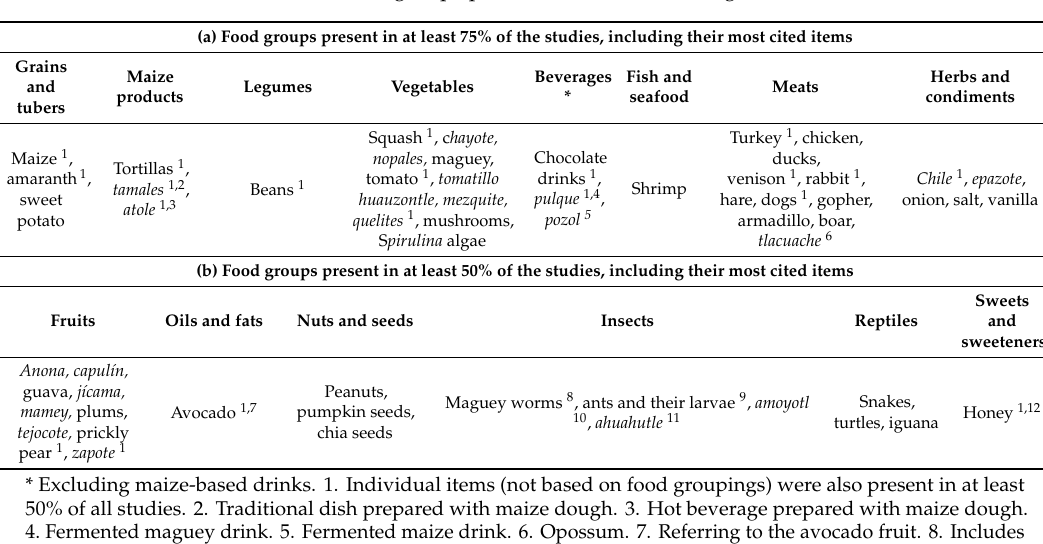
Table 6. Most cited items and food groups present in studies referring to Central Mexico ( n =